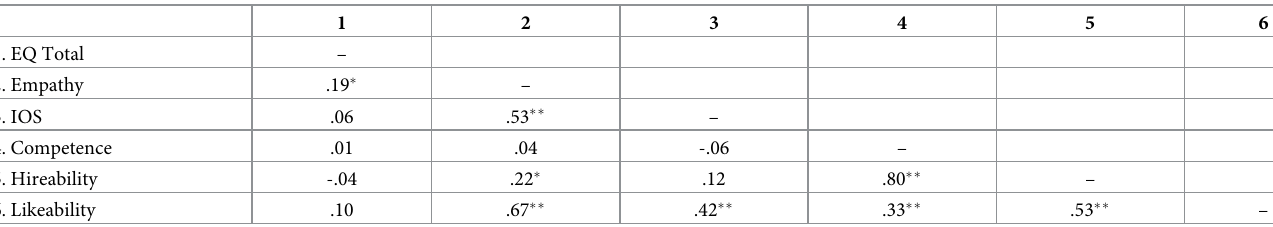
Table 11. Zero order correlations–female candidate.